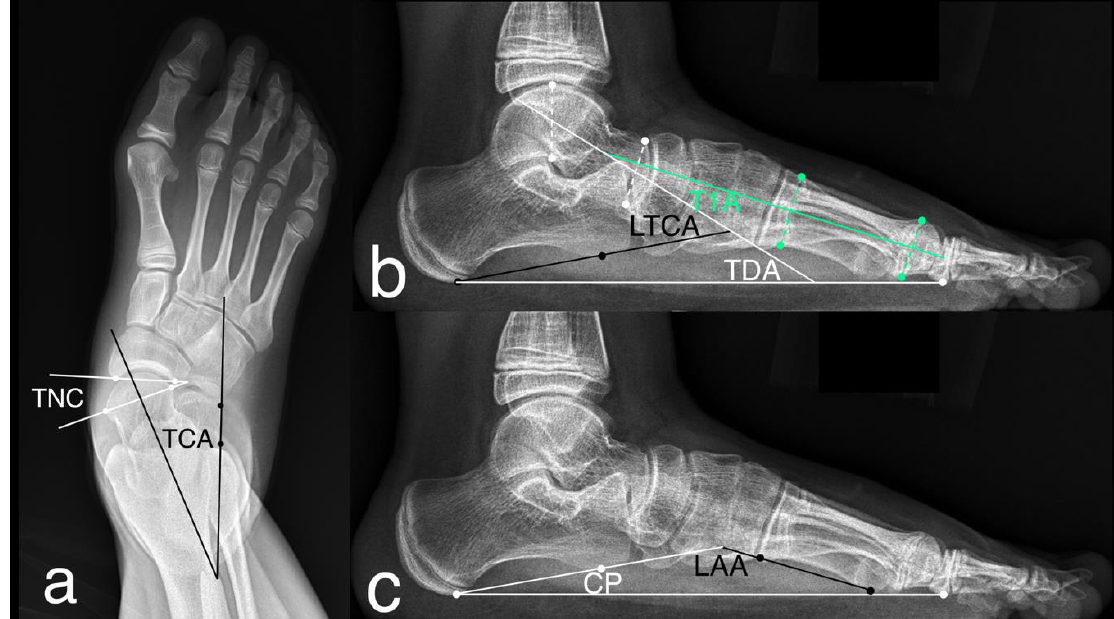
Figure 2. The radiographic measurements for flatfoot on anterior–posterior (AP) and lateral weight-bearing radiographs. ( a ) Talonavicular coverage (TNC) and talocalcaneal angle (TCA) on AP view; ( b ) talar–first metatarsal angle (T1A), talar declination angle (TDA) and lateral talocalcaneal angle (LTCA) on lateral view; ( c ) longitudinal arch angle (LAA) and calcaneal pitch (CP) on lateral view.